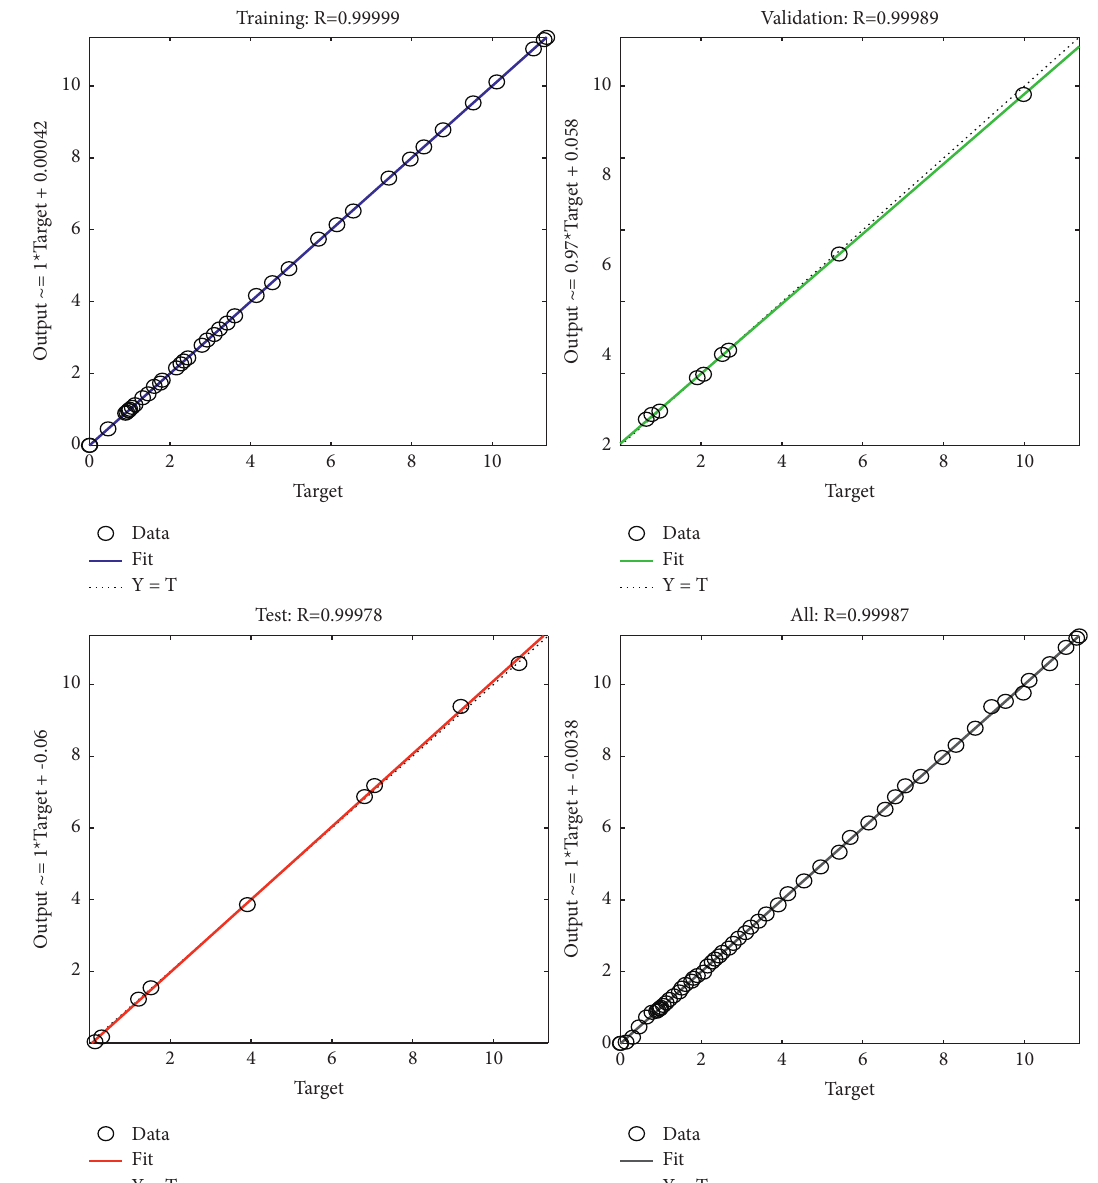
Figure 9: Neural network training regression analysis (optimal performance at 30 neurons in the hidden layer for Scheme